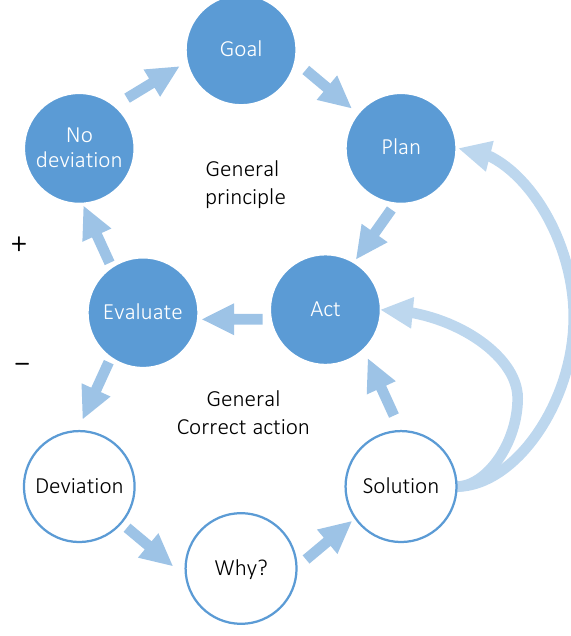
Figure 1. Main principle of innovative